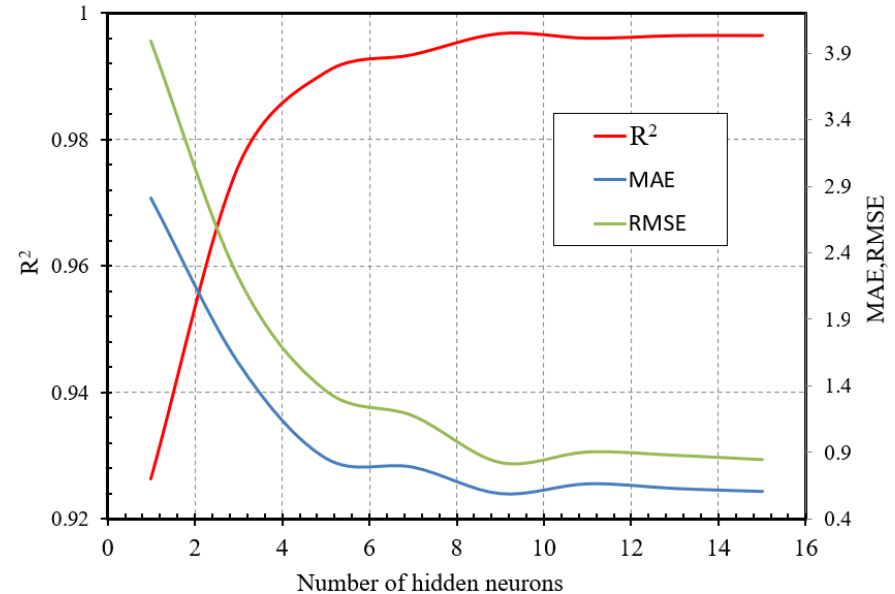
Figure 6. Performance of the ANN models .